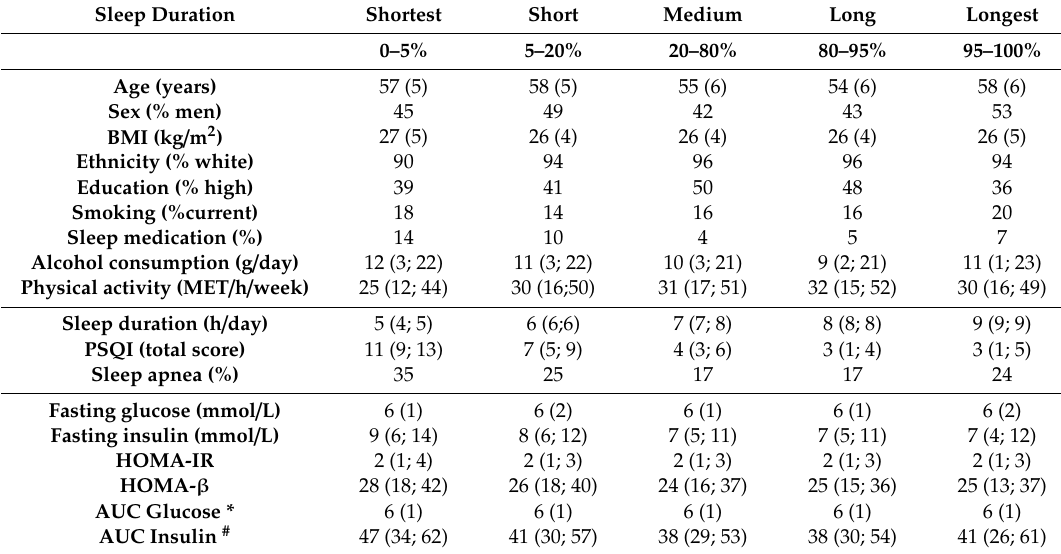
Table 1. Characteristics of participants in the Netherlands Epidemiology of Obesity study, stratified by sleep duration ( n = 4672).